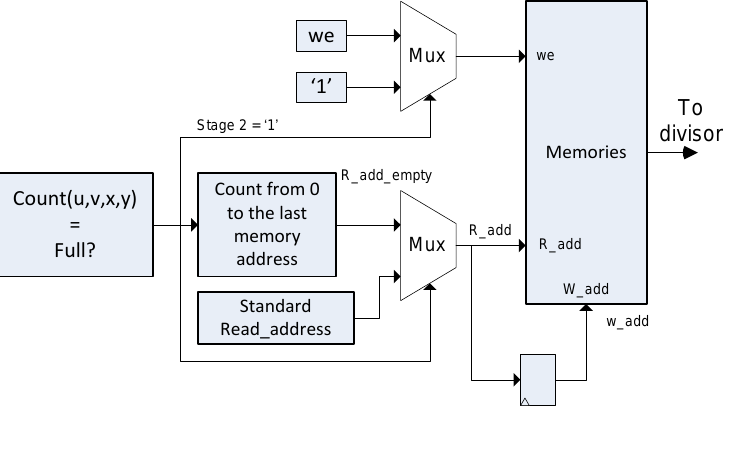
Figure 7. Switching between modes of accumulation and dump/erase of the